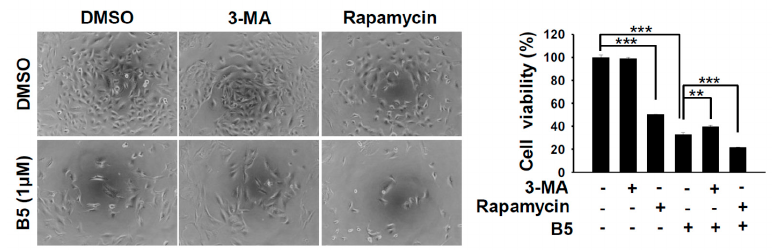
(10 μ M) for 48 h. Autophagosome (yellow) and autolysosome (red) puncta were observed using confocal microscopy. DMSO was used as a negative control. Rapamycin was used as an inducer of autophagy; chloroquine was a blocker of the autophagic flux.